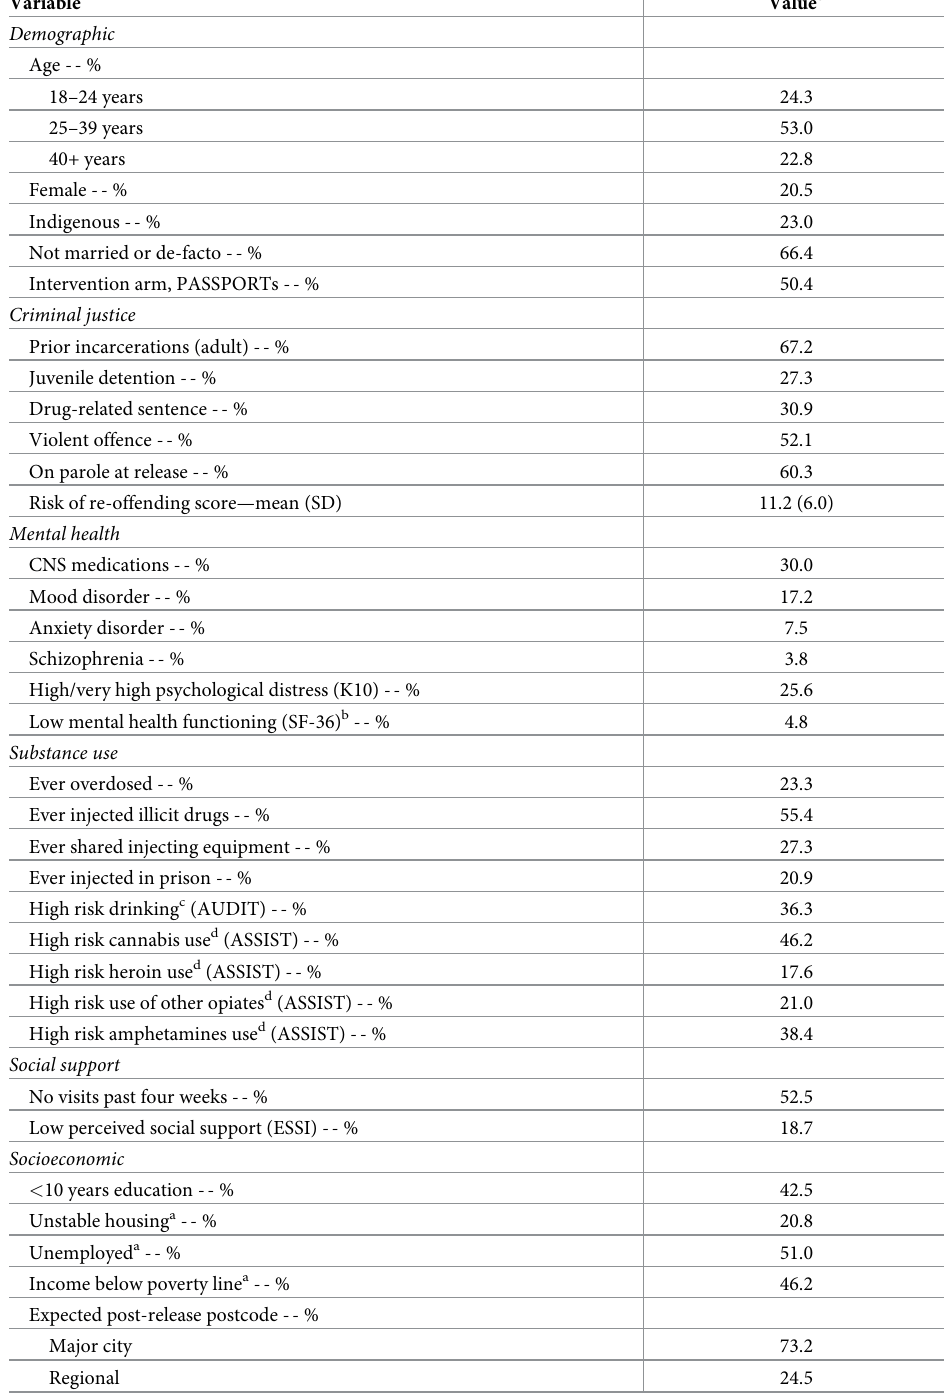
Table 1. Baseline characteristics of participants (n =